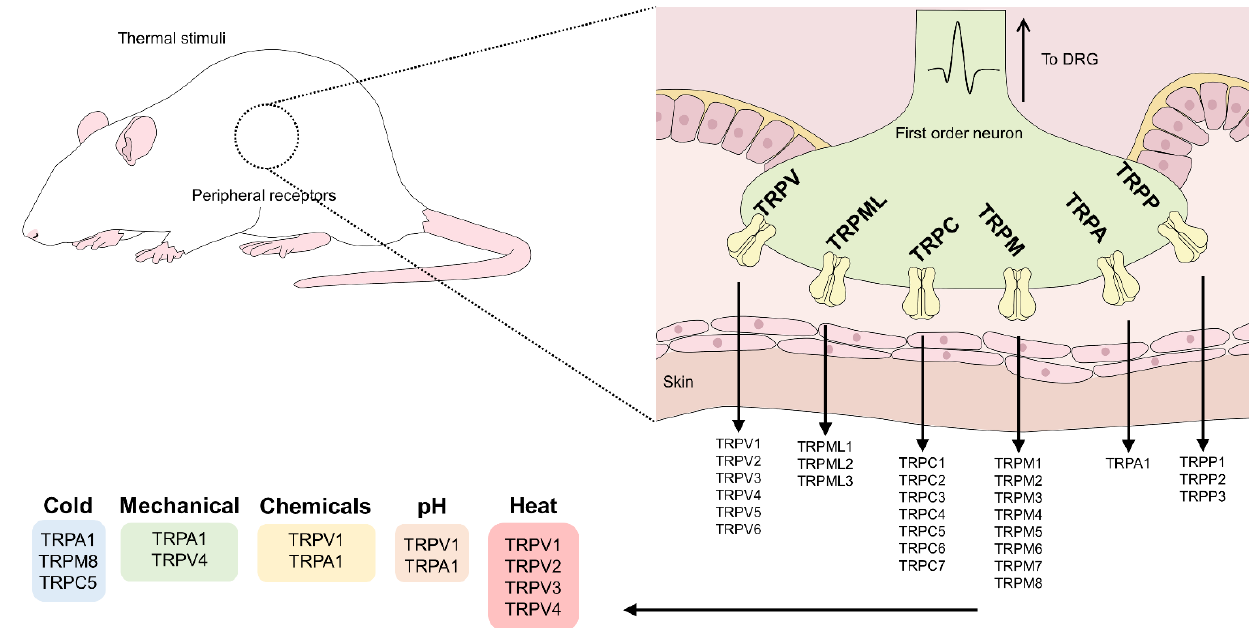
Figure 1. Families and subfamilies of TRP channels and their classification according to the type of stimulus they can perceive. DRG: dorsal root ganglion.